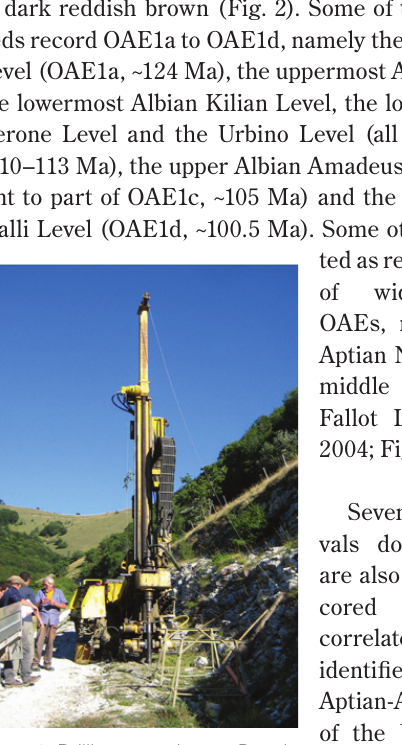
Figure 3. Drilling operations at Poggio le